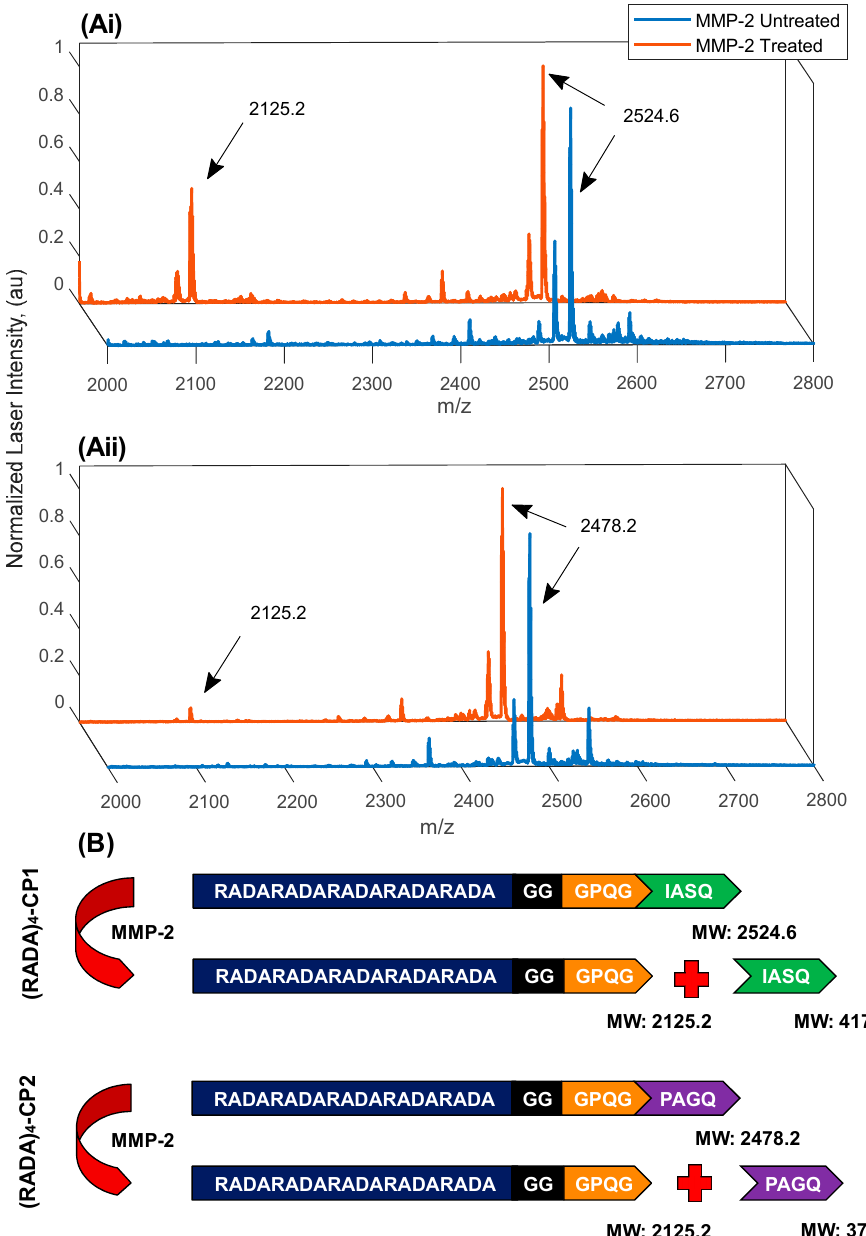
Figure 9. Matrix-assisted laser desorption/ionization time of flight (MALDI TOF/TOF) mass spectrometry of ( Ai ) 0.5% w / v (RADA) 4 -GG-GPQG+IASQ and ( Aii ) (RADA) 4 -GG-GPQG+PAGQ proteolysis. ( B ) Cleavage fragments are also shown. Incubated with 40 nM active MMP-2, in TNC buffer for three weeks at 37 °C. Substrate peaks are labelled 2524.6 m / z and 2478.2 m / z , representing theoretical molecular weights of (RADA) 4 -GG-GPQG+IASQ and (RADA) 4 -GG-GPQG+PAGQ, respectively. The peak 2125.2 m / z represents the molecular weight of the product for both substrates.